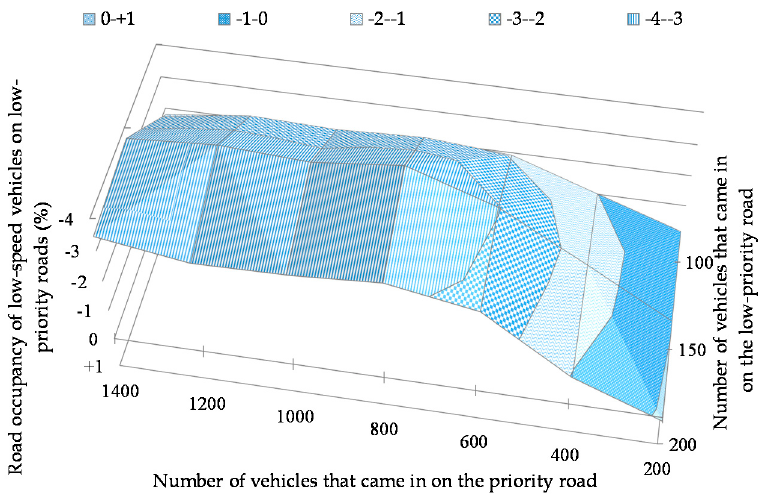
Figure 20. Variation in the road occupancy of low-speed vehicles on low-priority roads when the number of vehicles that came in was varied. The average driving speed was the average for the entire percentage range of self-driven vehicles.